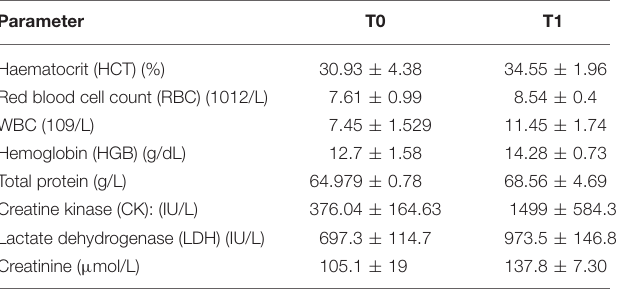
TABLE 1 | Hematological and biochemical parameters evaluated from the two time points. Parameter